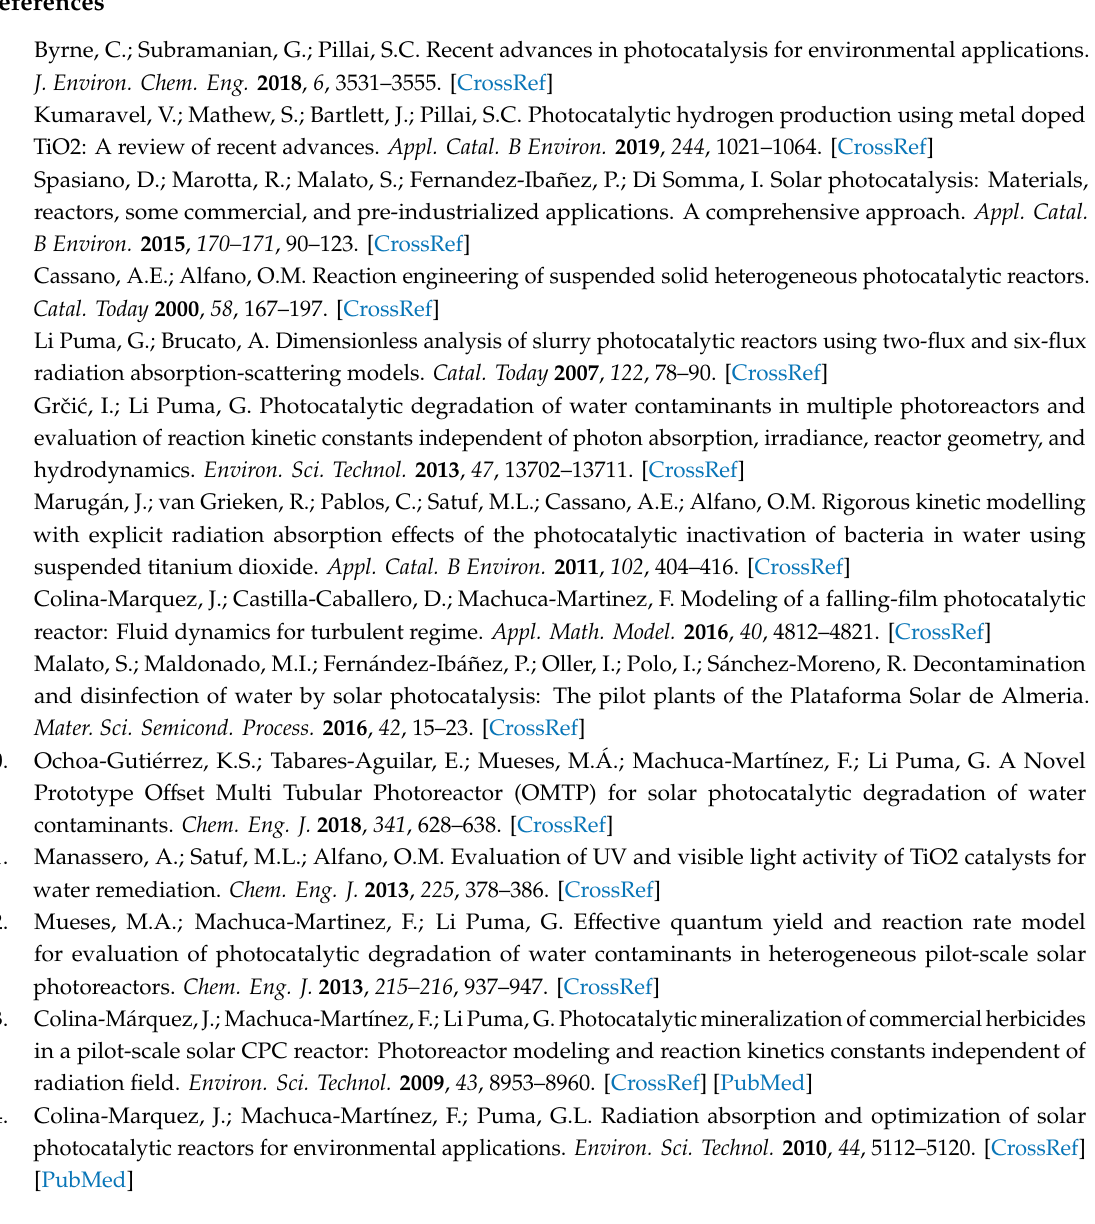
Figure S1: Radiation field simulation of a flat plate photoreactor (FPP) with